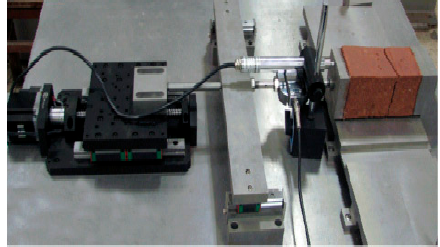
Figure 3. Direct connection (Bing-yin Zhang, 2015).